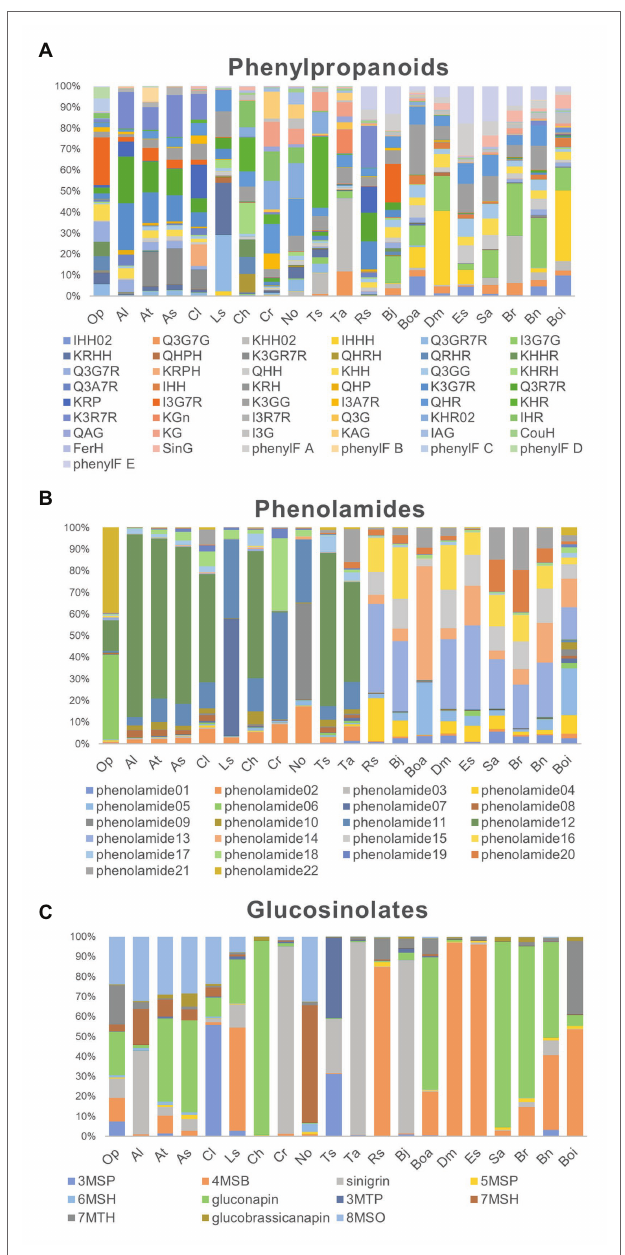
FIGURE 2 | Relative proportion of metabolites in each genotype. (A) The proportion of 49 phenylpropanoid compounds in each genotype; (B) The proportion of 22 phenolamides in each genotype; (C) The proportion of 11 glucosinolate compounds in each